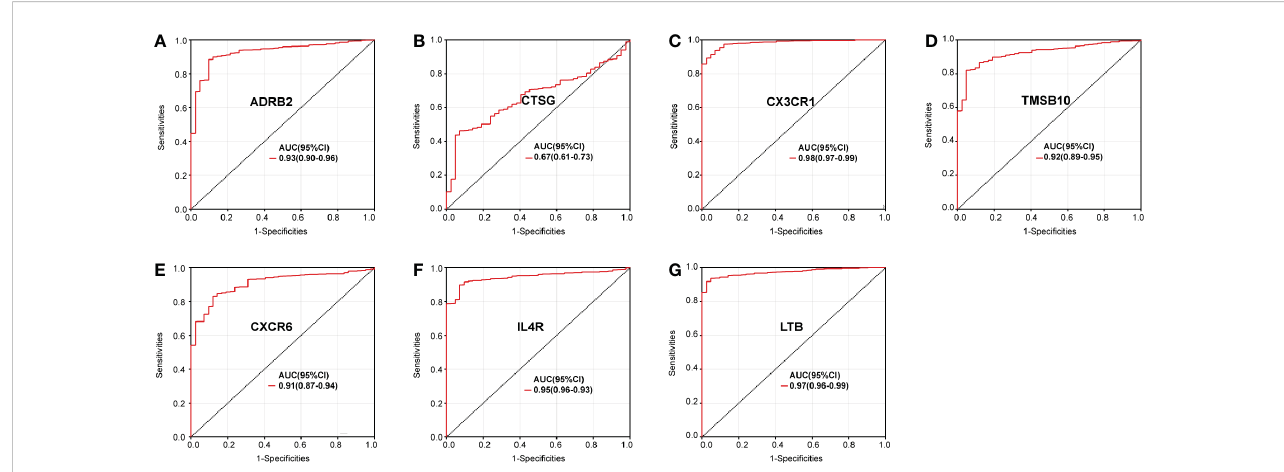
FIGURE 2 Diagnostic value of the immune genes for sepsis assessed via ROC curve analysis: (A) ADRB2, (B) CTSG, (C) CX3CR1, (D) CXCR6, (E) IL4R, (F) LTB, and (G)